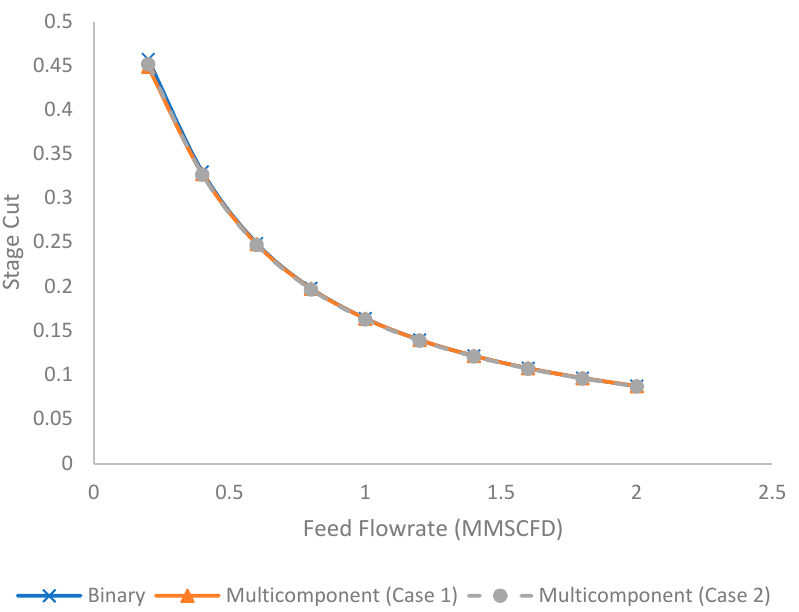
Figure 8. Evolution of permeate acid gas composition under different feed pressure for binary and multicomponent system.